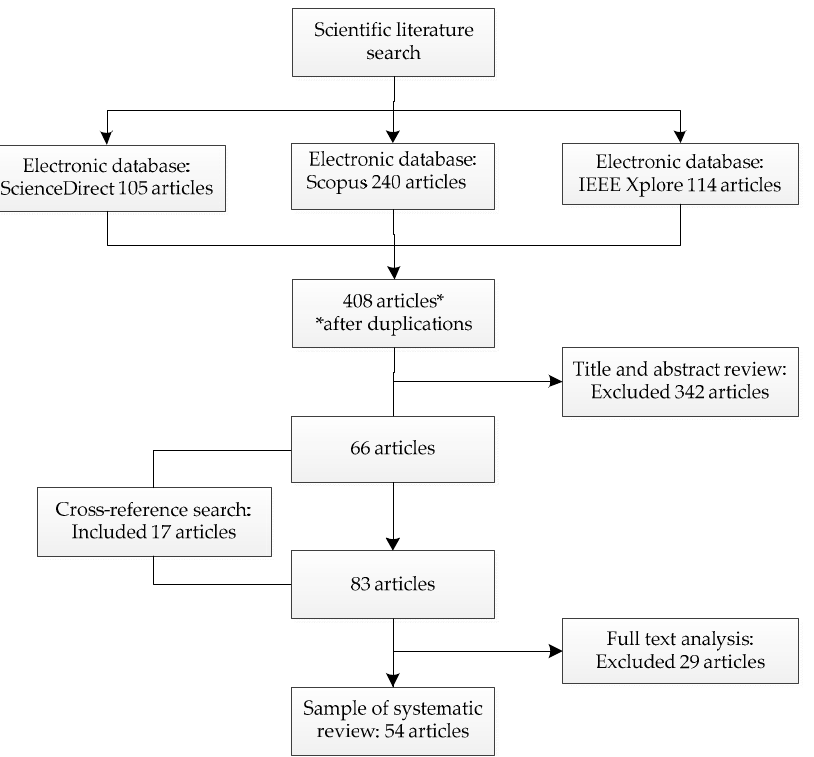
Figure 1. Flow diagram of review process.